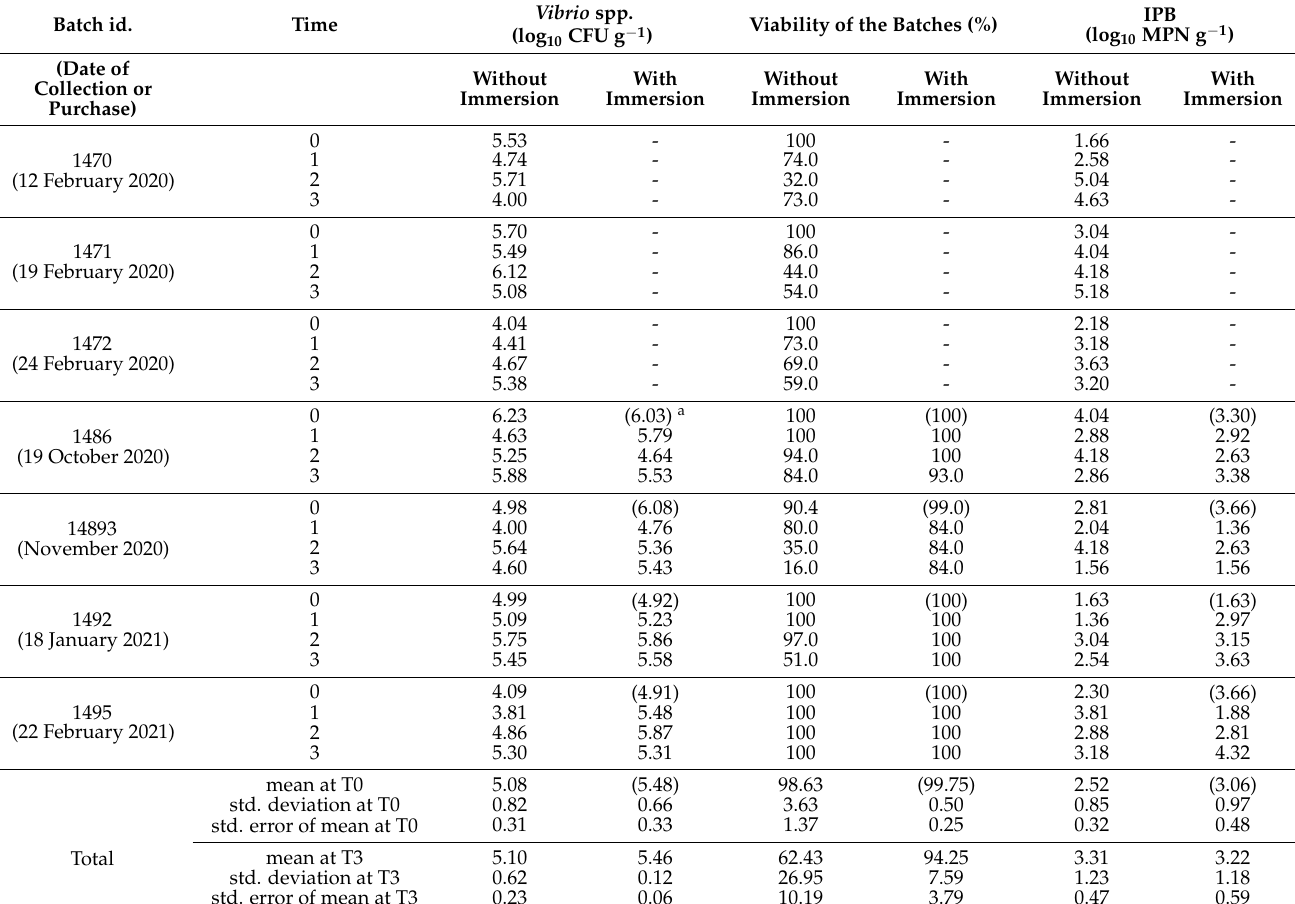
Table 3. Viability of the batches of Tritia mutabilis , Vibrio spp. load, and IPB load. Batches at harvest (T0) and refrigeration at 4 ◦ C. T1–T3 = day of refrigeration with and without immersion. Batch